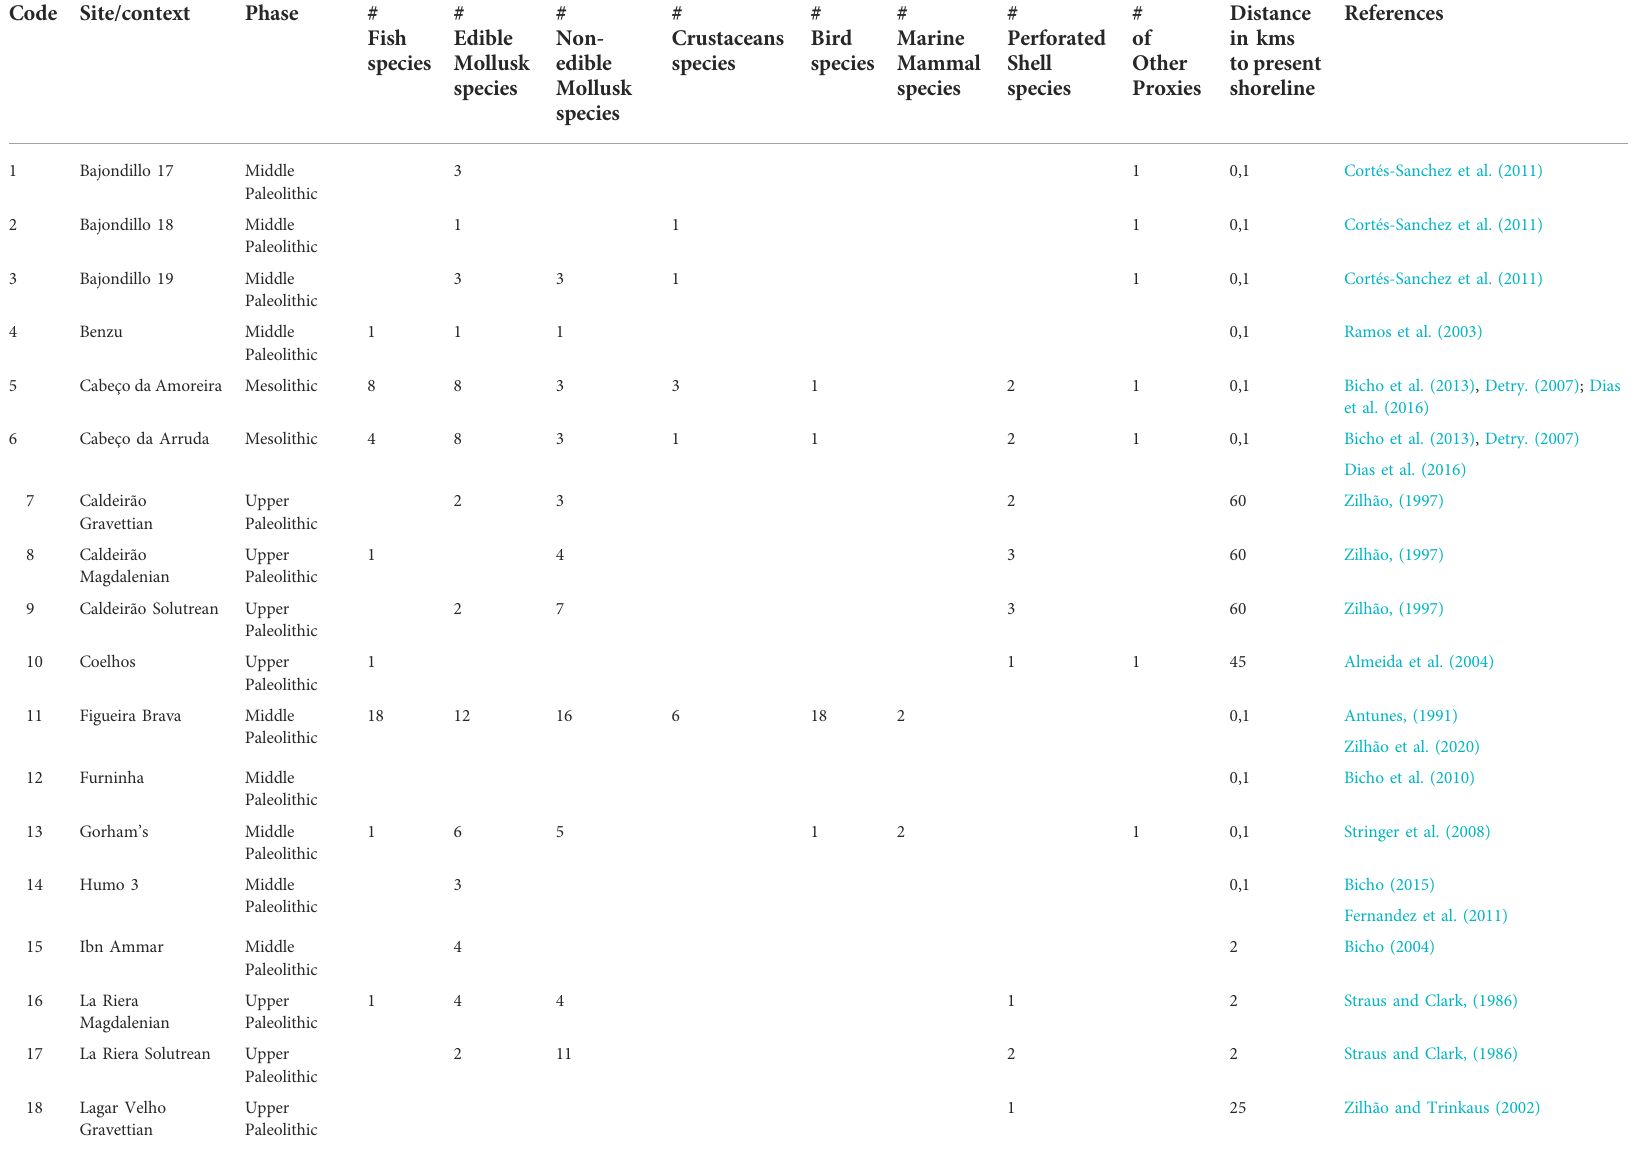
TABLE 1 List of sites used for the PCA analyses (Serrano Lozano et al.,